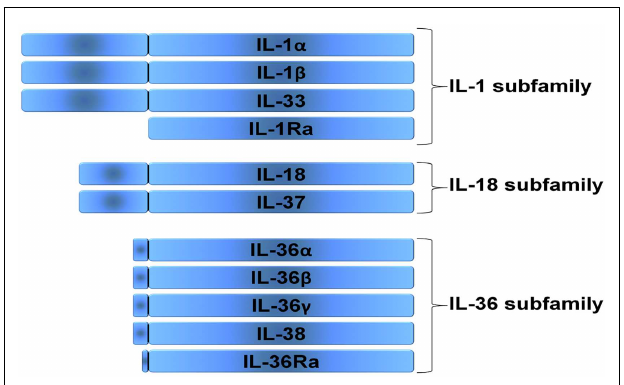
FIGURE 1 | Subfamilies according to the length of their precursor . Three families can be distinguished in the IL-1 family, the IL-1 subfamily, the IL-18 subfamily, and the IL-36 subfamily.The IL-1 receptor antagonist (IL-1Ra) cannot be categorized in these subfamilies, since it has a signal peptide and is readily